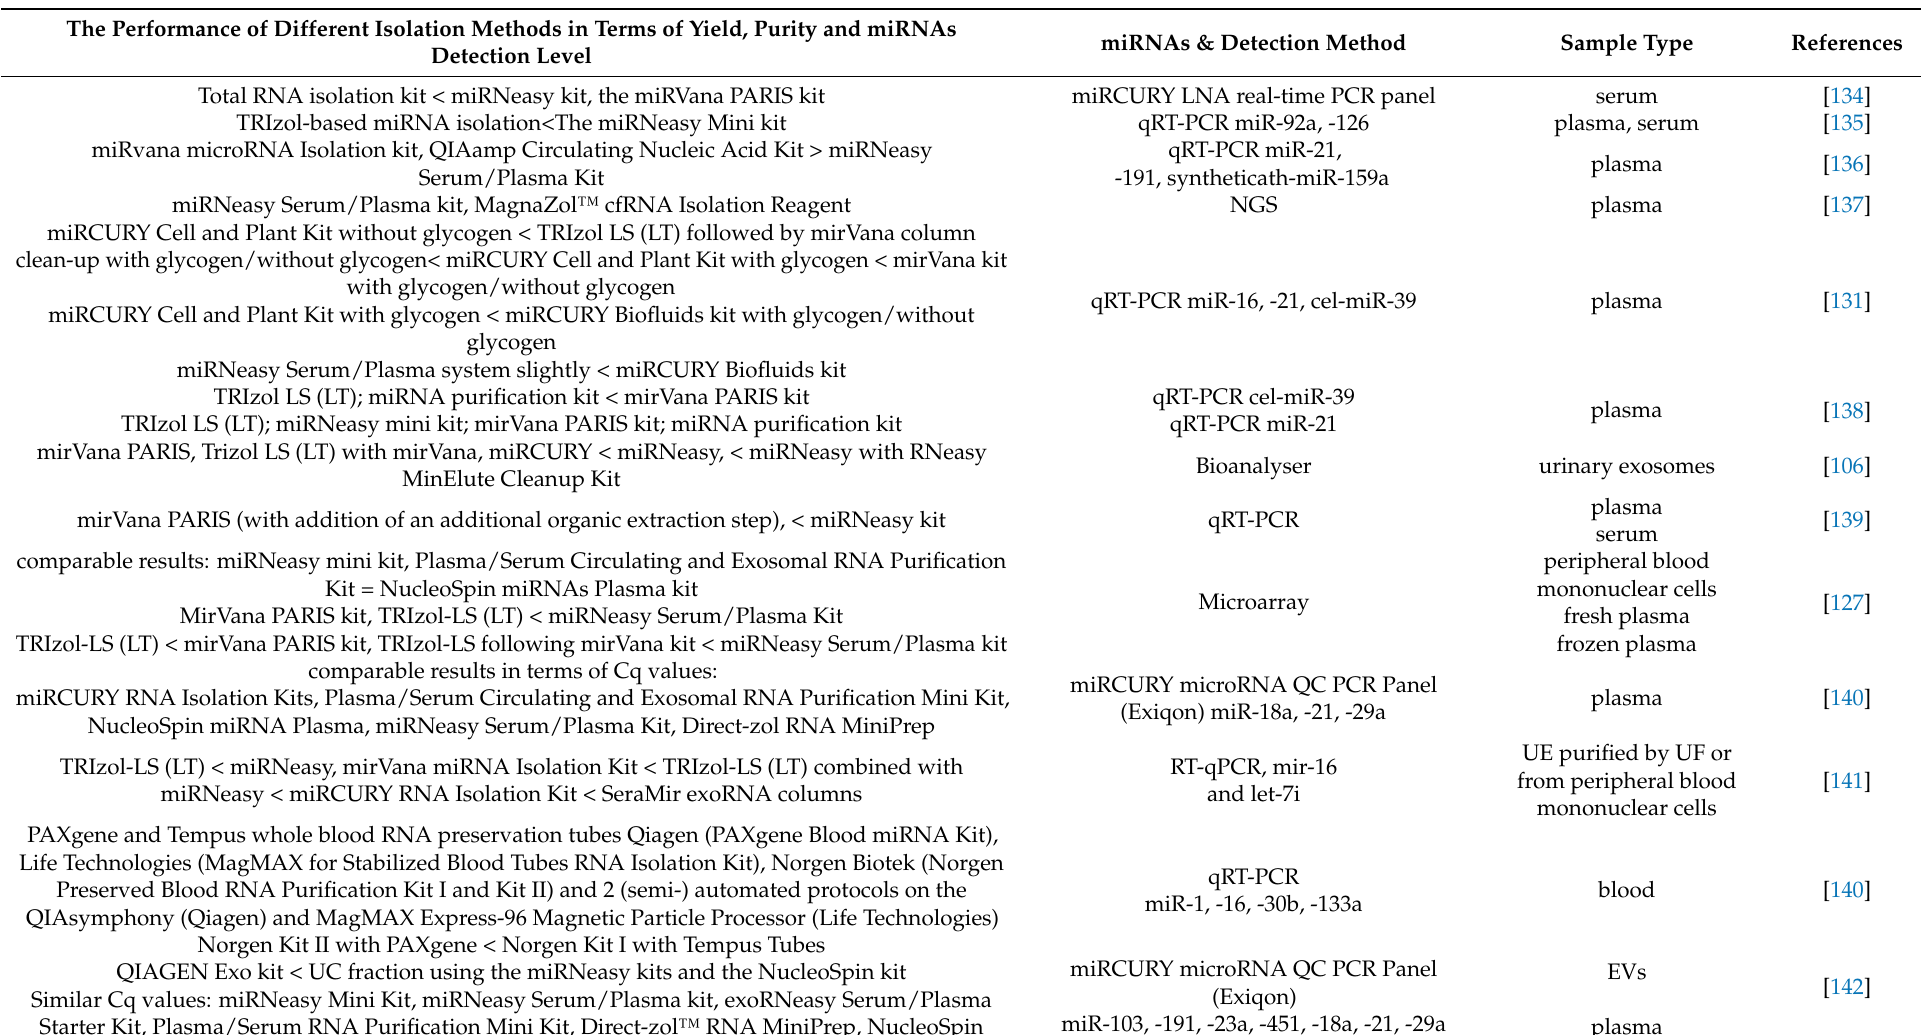
Table 3. Comparative studies of different miRNA isolation